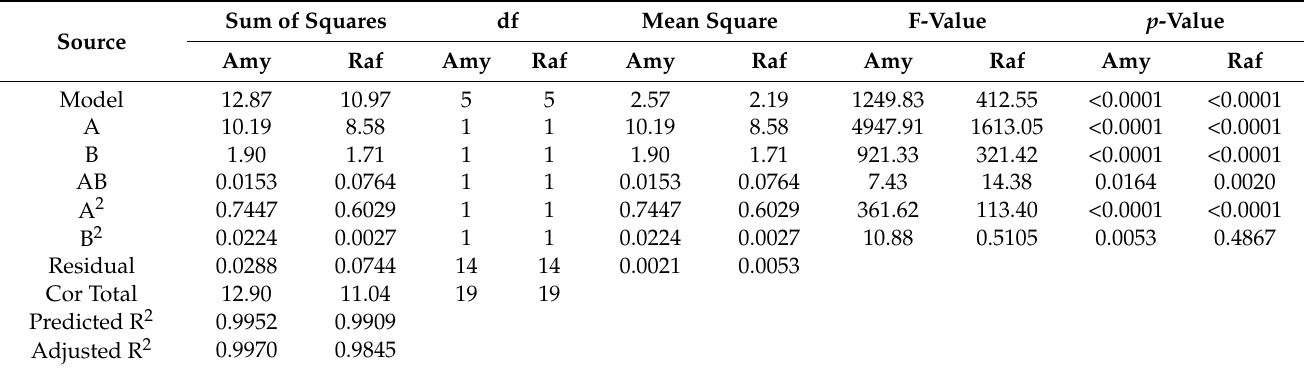
Table 9. ANOVA result for quadratic regression model for Al corrosion inhibition in 0.1 M NaOH medium by the examined